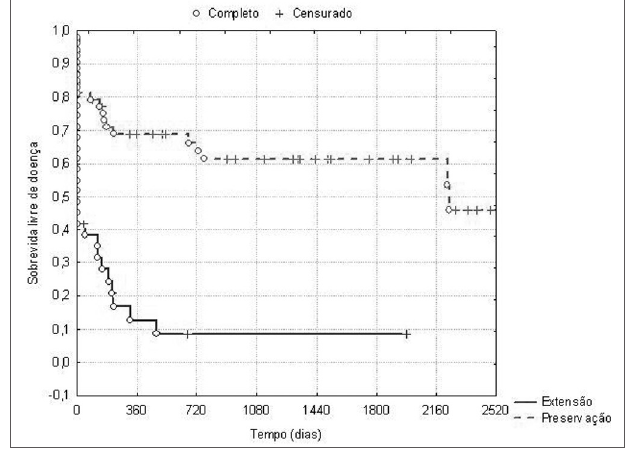
Sítio*/Radioterapia